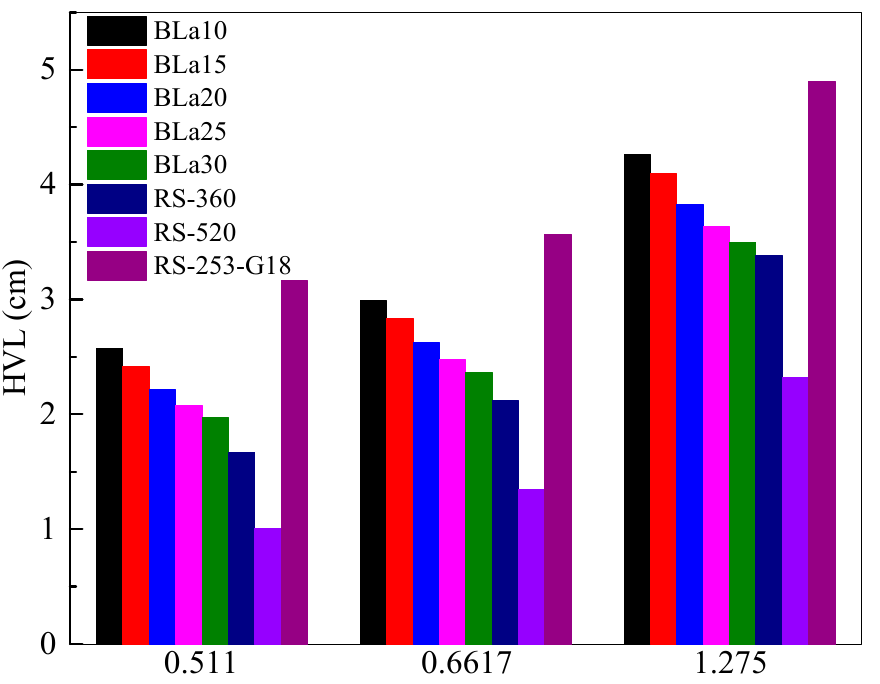
Figure 7. Comparison with the commercial shielding glasses.